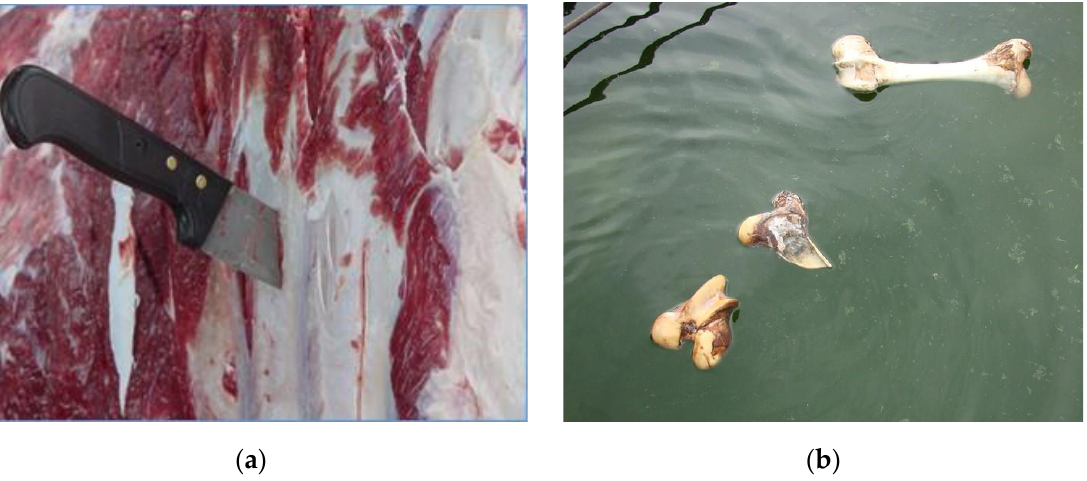
Figure 7. ( a ) Rib from buffalo with clinical P deficiency being easily cut by the necropsy knife [23]. ( b ) Bones of cattle with clinical P deficiency floating in water [23].